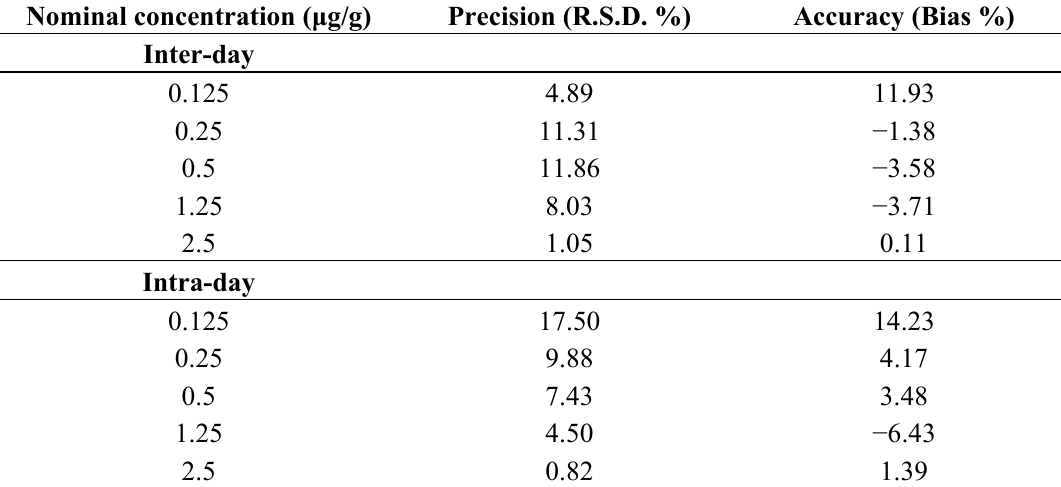
Table 2. Method validation for the intra-assay and inter-assay precision (R.S.D.%) and accuracy (Bias%) of the UPLC-MS/MS method for the determination of DBP in rat feces. Nominal concentration ( μ